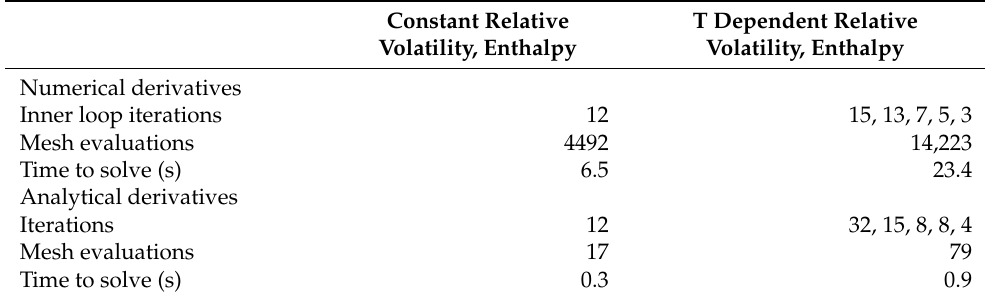
Table A2. Comparison of the number of function evaluations in the solution of the MESH equations for the Luyben case with N stages = 21. T-dependent properties are taken for the methyl acetate system (methanol+acetic acid ↔ methyl acetate+water) using the ideal gas law. Number of values given for the iterations corresponds to the number of outer loop